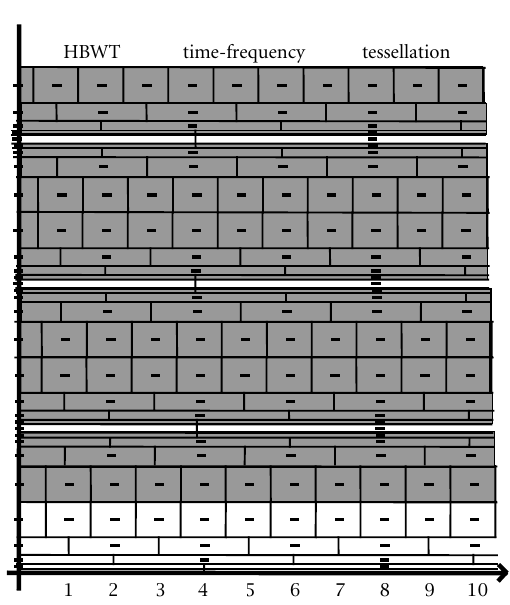
Figure 10: Spectral subdivision, dotted: deterministic component, gray: pseudo-periodic 1 /f -like model, dark gray: shot noise